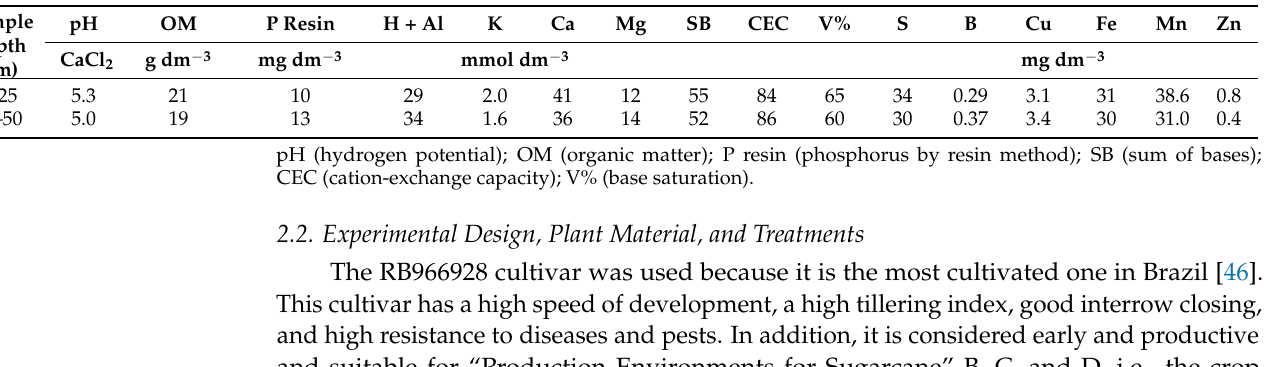
Table 1. Initial soil chemical analysis from the soil of the experimental area.